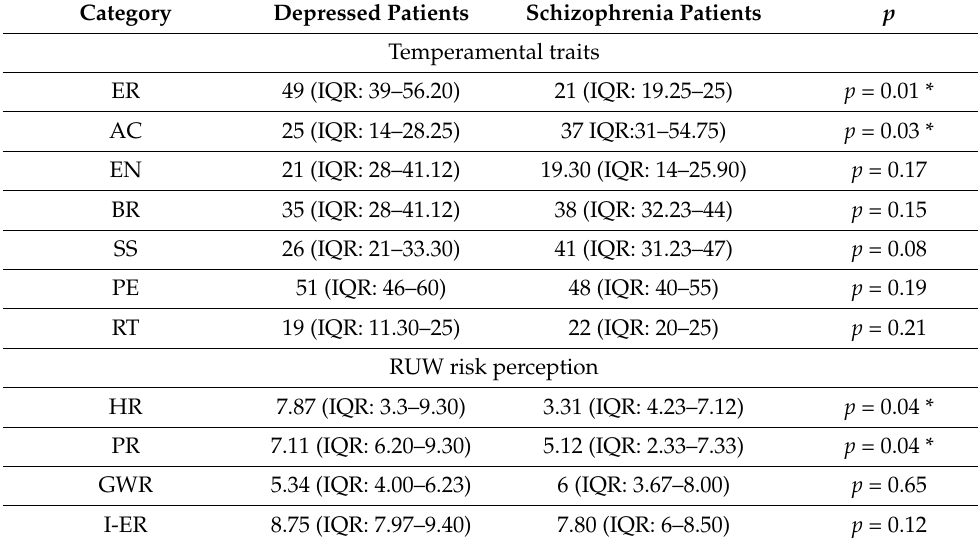
Table 2. Differences between groups on RUW risk perception and temperamental traits (before and after exposure of